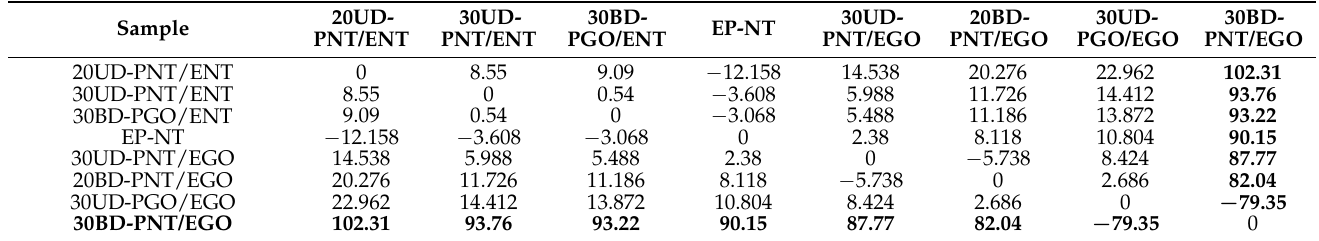
Table 7. Tukey’s test ADM of the ballistic tests’ mean